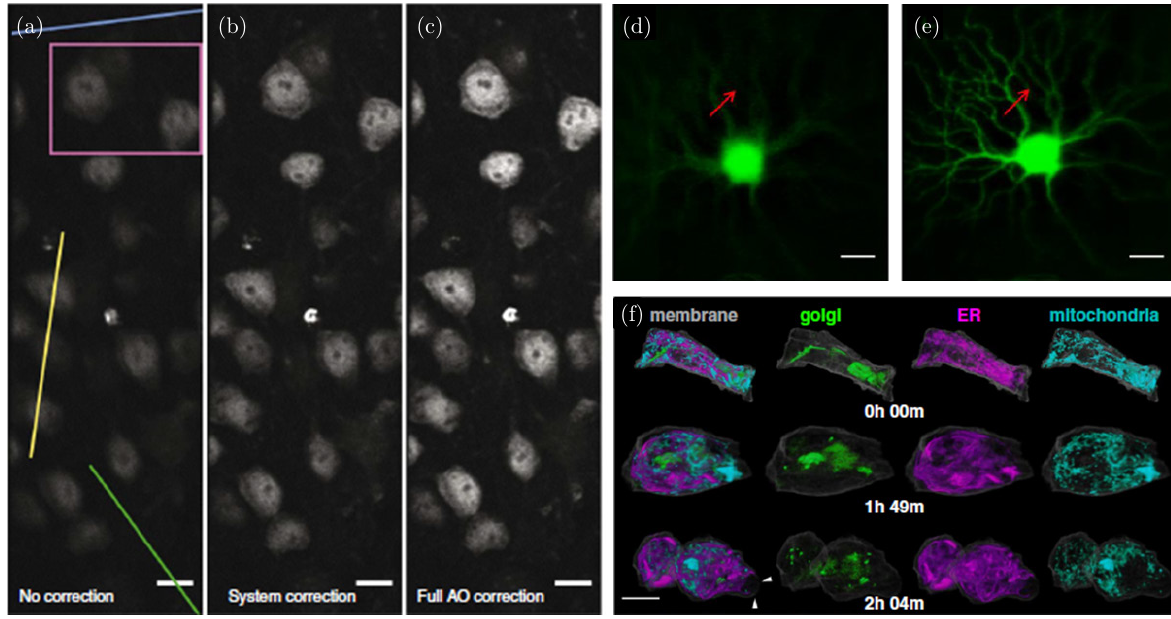
Fig. 1. AO is a general approach that can be applied to all imaging modalities. (a) Two photon imaging of neurons in 300 (cid:1) m brain slice, (b) After correcting for system induced aberrations, (c) After correcting for both system and sample induced aberrations using pupil segmentation-based wavefront sensing. 61 Scale bars 10 (cid:1) m , (d) Confocal °uorescence imaging of retinal ganglion cells, (e) After application of wavefront sensorless Zernike modal-based AO. Red arrows highlight ¯ne structures originally invisible that can now be seen. 64 Scale bars 20 (cid:1) m and (f) 4D high spatiotemporal imaging of entire living organisms using lattice lightsheet and direct wavefront sensing AO. 65 Scale bar 10 (cid:1) m . Figures (a) – (c) reprinted with permission from Ref. 61, (d) – (e) from Ref. 64, and (f) from Ref.